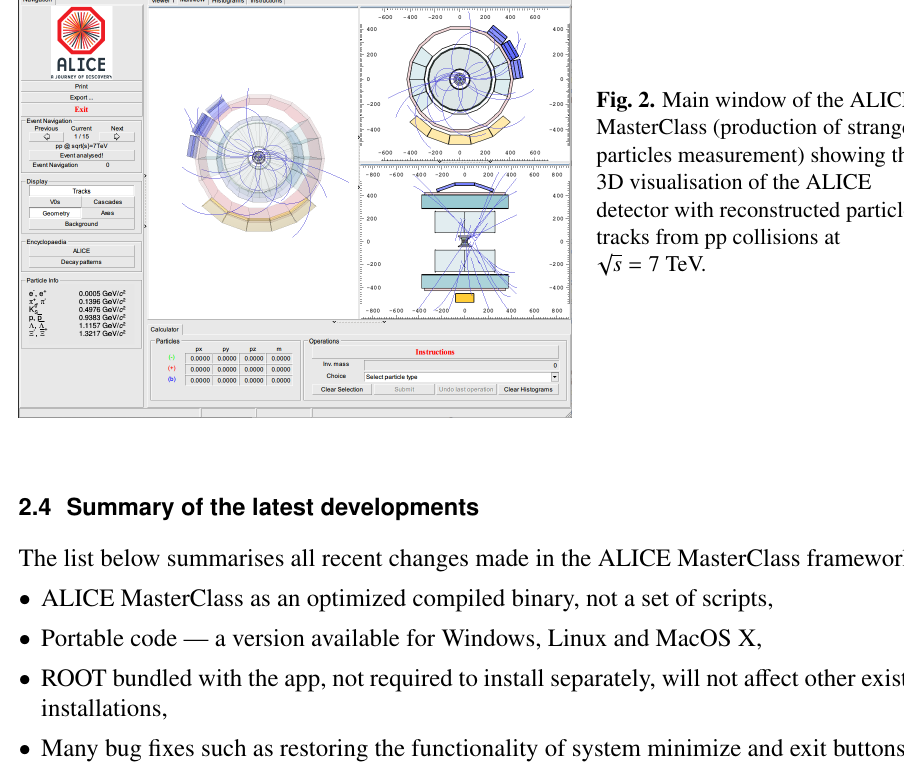
Fig. 2. Main window of the ALICE MasterClass (production of strange particles measurement) showing the 3D visualisation of the ALICE detector with reconstructed particle tracks from pp collisions at √ s = 7